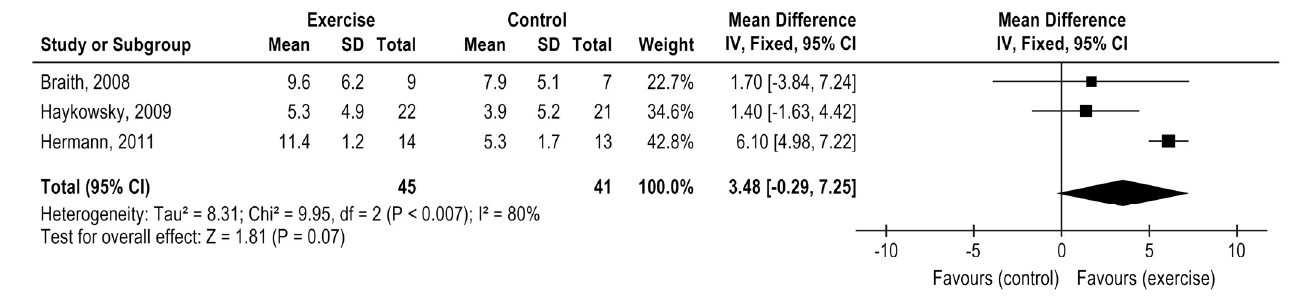
Figure 5. Impact of exercise training on VE/V’CO2 slope in HTx.